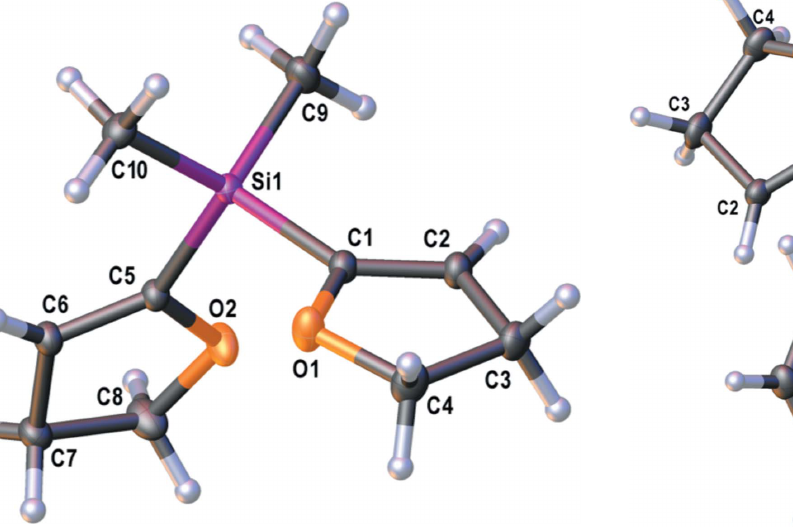
Figure 1 The molecular structure of compound 1 with displacement ellipsoids drawn at the 50% probability